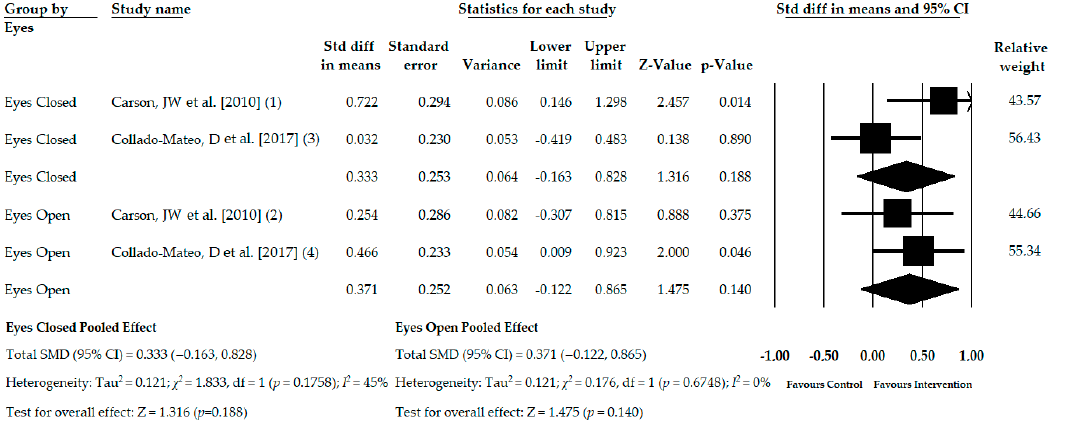
Figure 5. Forest plot of the meta-analysis of the immediate effect of the ATBT in the balance assessment on unstable support with eyes open and